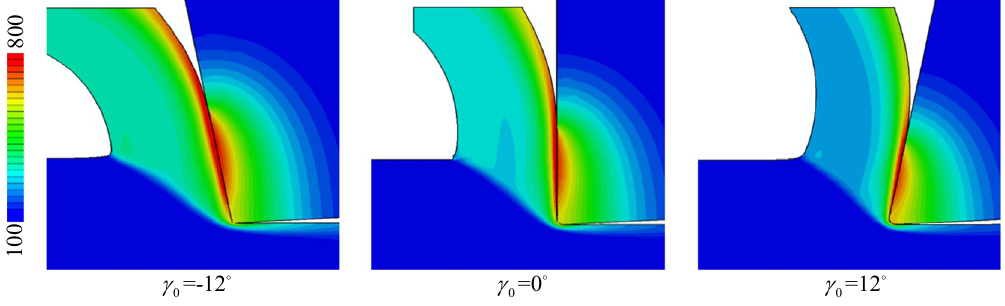
ff ect of rake angle on tool temperature field Figure 4. Effect of rake angle on tool temperature field [33]. Figure 4. E